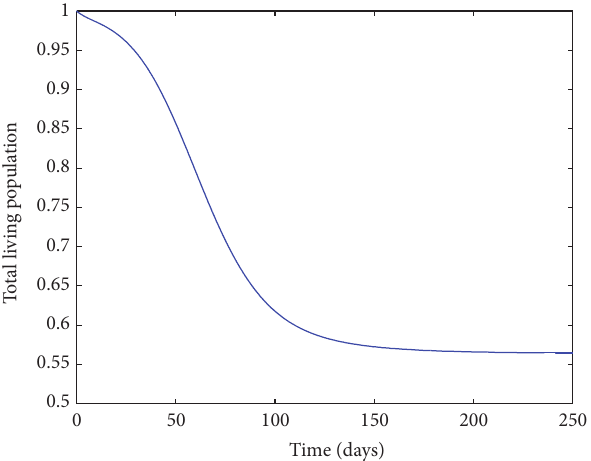
Figure 2: Natural evolution of the total alive population.